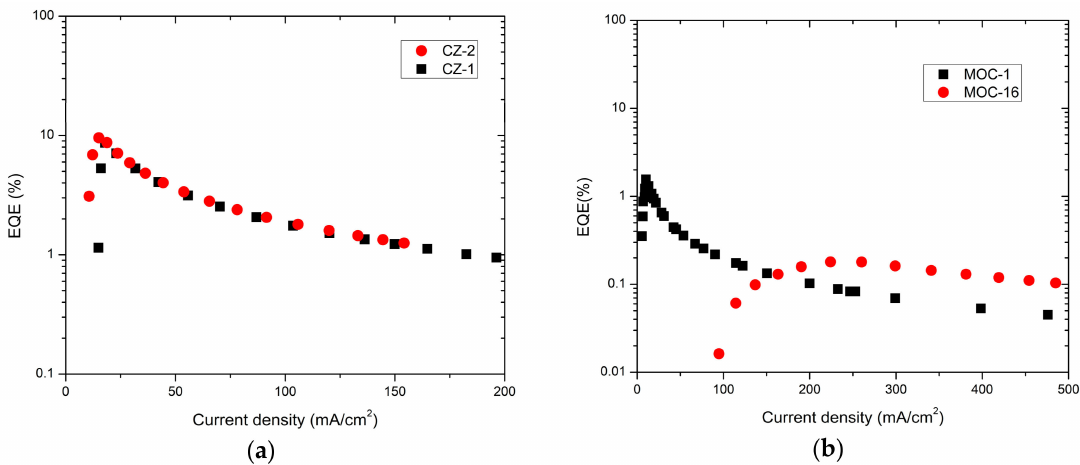
Figure 7. EQE of ( a ) devices based on carbazole derivatives (CZ-2 and CZ-1) and ( b ) TPD derivatives (MOC-1 and MOC-16).